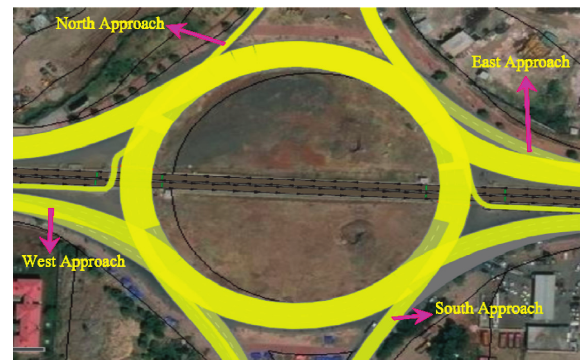
Figure 2: Snapshot of the VISSIM model with the vehicle routes for CMC roundabout intersection.